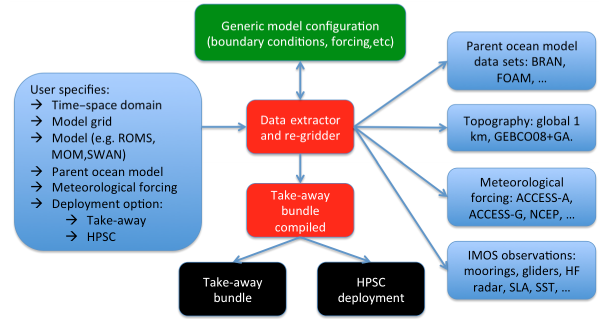
Figure 1. Schematic outlining the steps in WebMARVL. User re- quirements are specified through the WebMARVL interface. The system then selects the grid, the model(s), the parent model(s) for initialisation and boundary conditions, the topography, and meteo- rological forcing. The system subsequently interpolates the inputs to the specified grid requirements. Depending on the deployment option (a) the files are bundled up as a take-away package or (b) de- ployed to a high-performance supercomputer